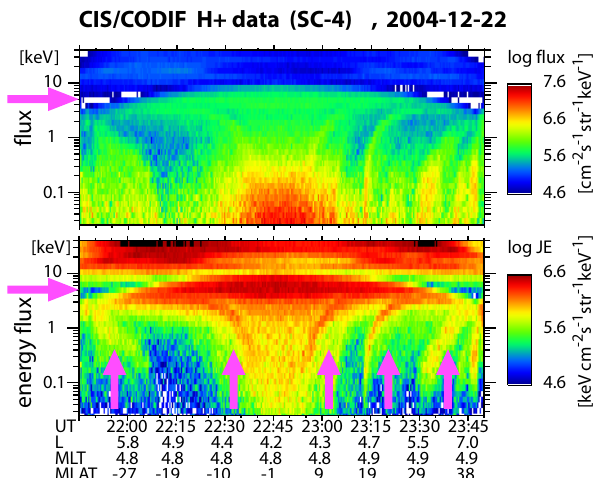
Fig. 2. Same as Fig. 1 except date (22 December 2004), energy range (0.03–40keV), and color scale. The contamination from MeV particles of radiation belt is seen at around 22:30 ∼ 23:00UT. The band-like structure is marked by horizontal arrows and the wedge- like energy-latitude sub-keV ion structure is marked by vertical ar- rows. One can recognize clear gap between the band-like structures at high energy ( > 10keV) and at low energy ( <